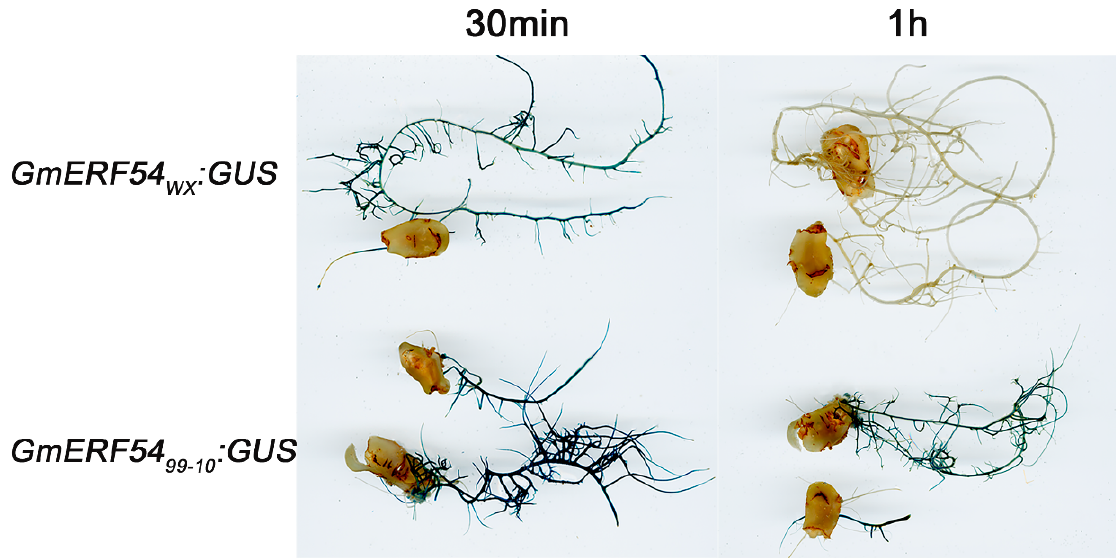
Figure 6. GUS staining of GmERF54 WX :GUS and GmERF54 99-10 :GUS transgenic hairy roots with exposure to CCW attack. The GmERF54 WX :GUS and GmERF54 99-10 :GUS recombinant vectors represent the promoter fragments from WX (insect-resistant cultivar) and 99-10 (insect-susceptible cultivar), respectively.